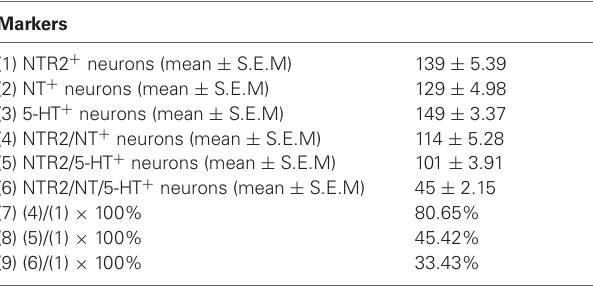
Table 2 | The number of neurons immunopositive for NTR2, NT, 5-HT, and all three markers in the RVM ∗ .